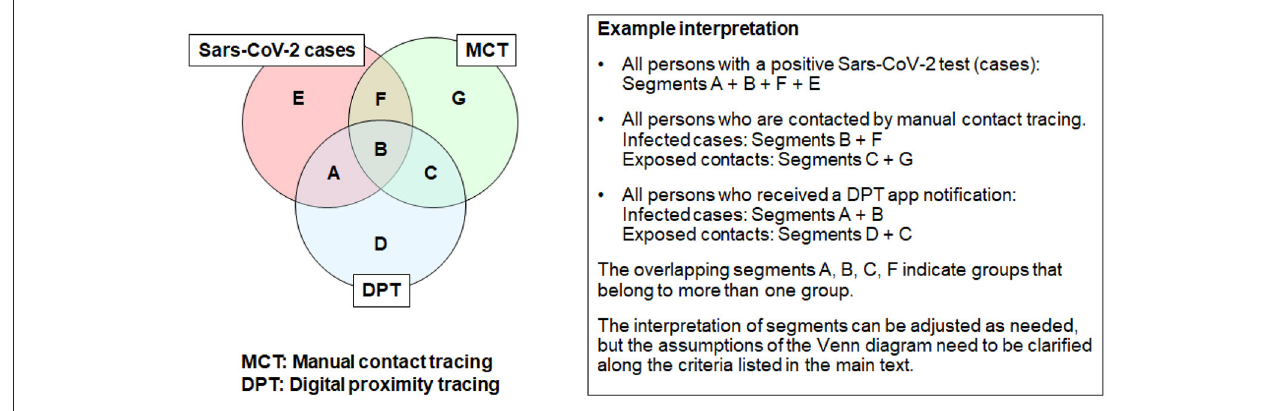
FIGURE 4 | Example use of Venn diagrams to define denominators for KPIs and public health metrics (courtesy of https://pact.mit.edu/).